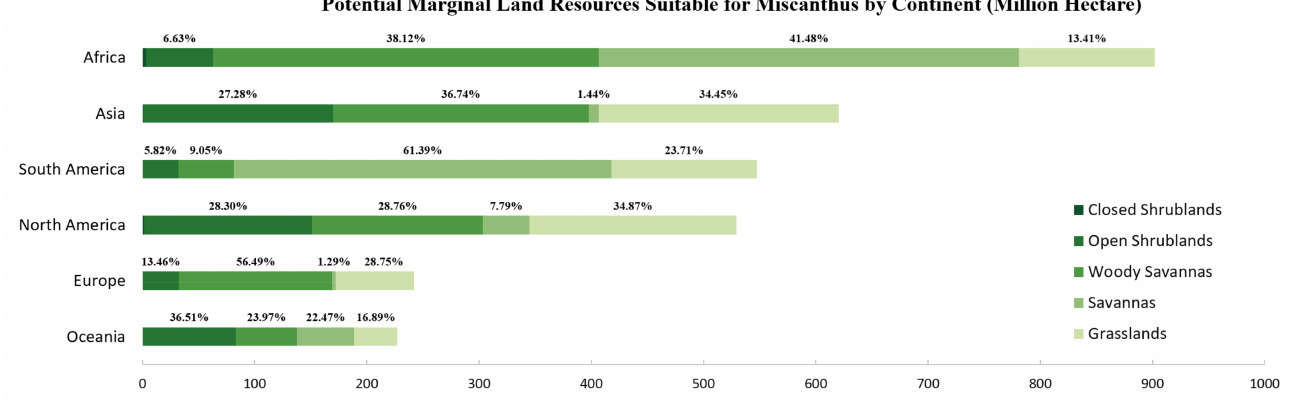
Figure 6. Bar chart with the percentages of all land-use types in each